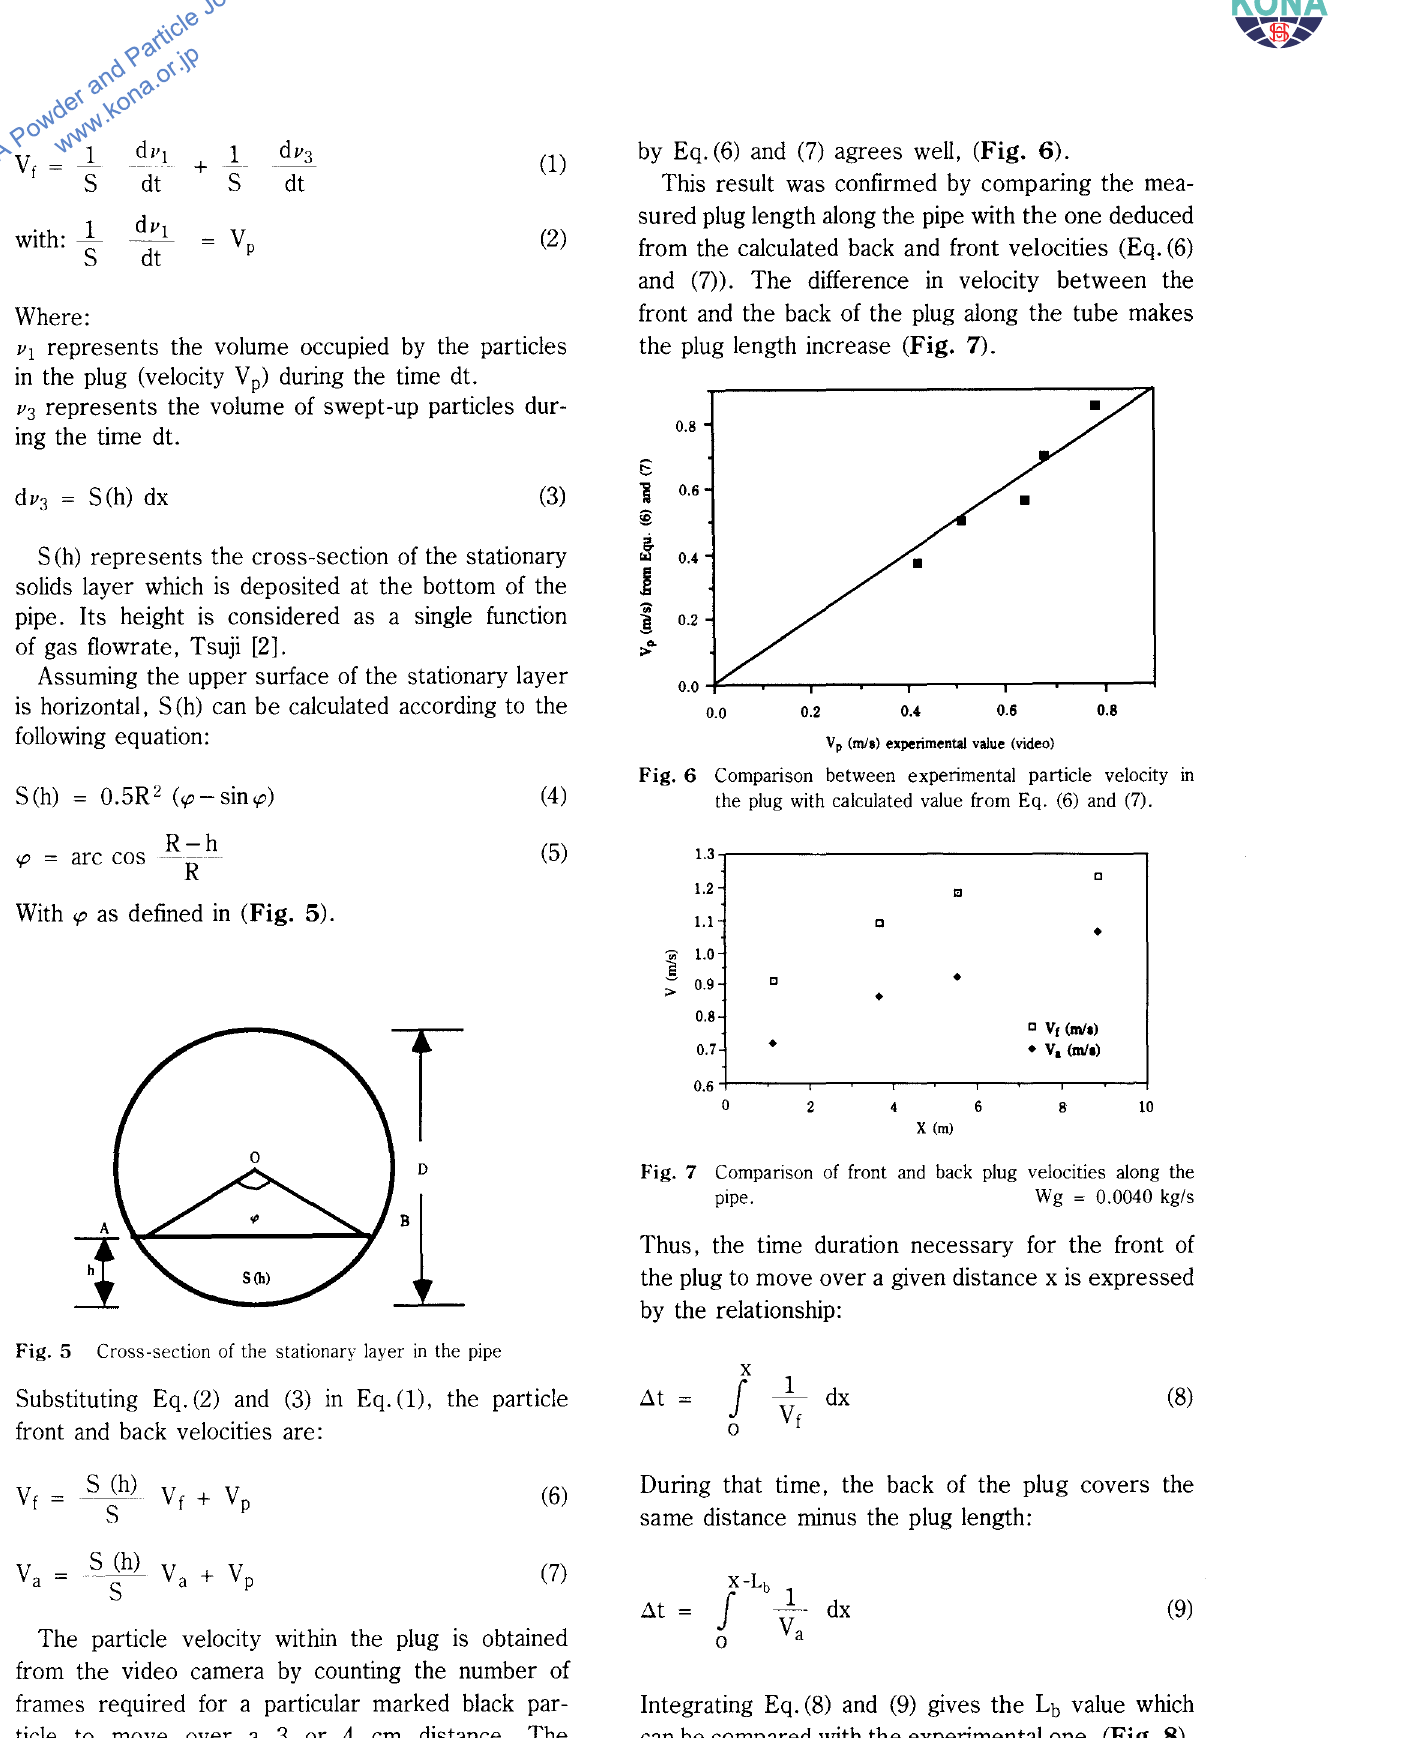
Cross-section of the stationary layer in the pipe